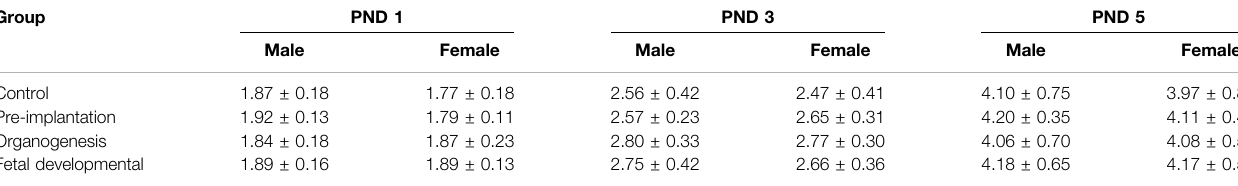
TABLE 3 | Body weight [g] of offspring at postnatal days (PND) 1, 3, and 5.